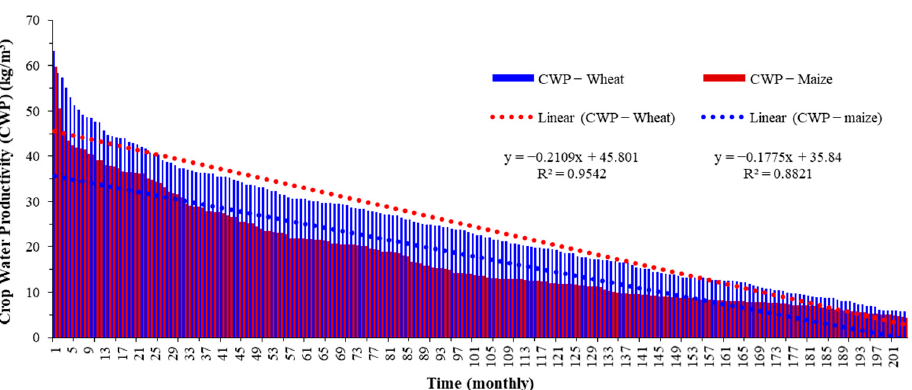
Figure 7. Comparative trend analysis of decreasing order (higher to lower magnitudes) of crop water productivity (CWP) for wheat and maize across the study period 1969–2019.